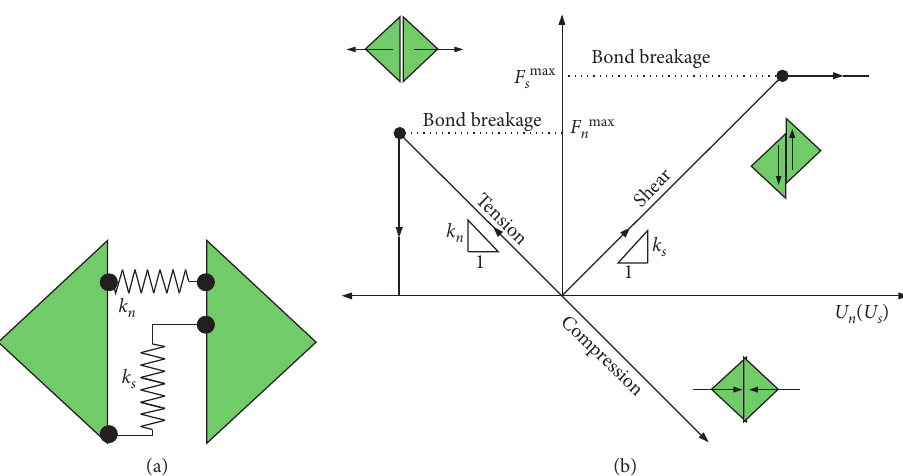
Figure 4: Using UDEC Trigon method to simulate the propagation process of rock mass fracture: (a) tangential and normal stiffness between blocks; (b) constitutive and failure behavior of tensile and shear strength between